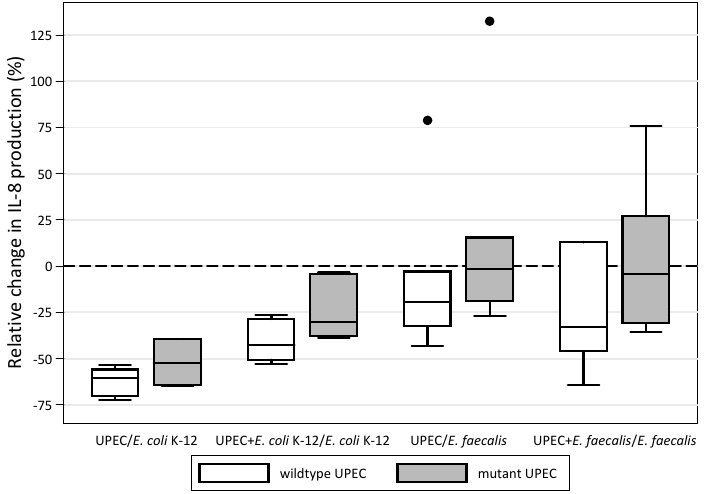
Figure 5. The four indices between the values of CXCL8 induced in the 5637 bladder epithelial cell line during in vitro monomicrobial and mixed infections (see Figure 1) are displayed as differently coloured box-plots for the seven wildtype and the seven isogenic mutant UPEC. The lines inside boxes represent the median value of the observations, and the lower and upper sides of the boxes are 25th and 75th percentile, respectively. The circles beyond the last bar represent the outliers as they exceed the 75th percentile plus one and a half times the interquartile range.